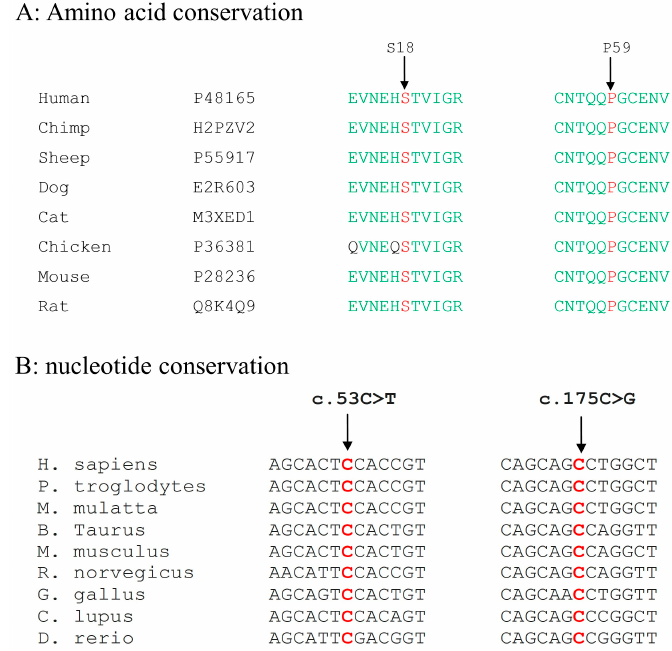
Figure 4. Multiple sequence alignment of GJA8 orthologues: ( A ) mutated amino acids p.(Ser18Phe) (S), and p.(Pro59Ala) (P) are indicated with an arrow and in red color; and ( B ) nucleotide conservation among the orthologous species is indicated with arrow and the wild type nucleotide is represented in red color.